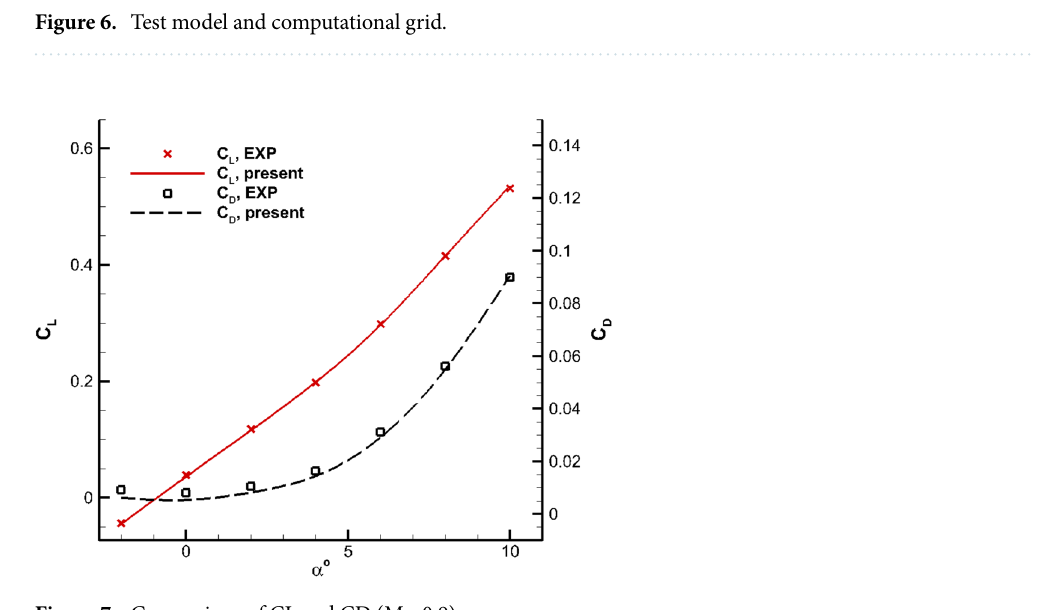
Figure 7. Comparison of CL and CD (M =